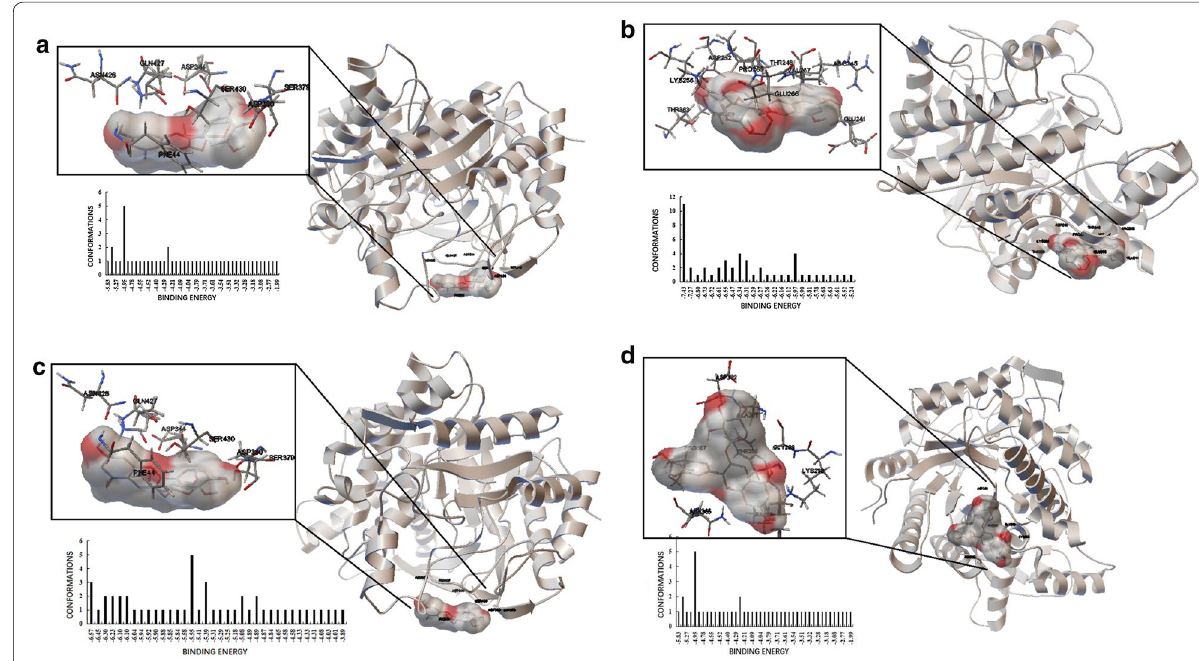
Fig. 6 Use Autodock software binding energy of 50 docking models. Panoramic view showing the binding mode between Cyanidin-3- O -arabinoside ( a ), Cyanidin-3- O -galactoside ( b ), Cyanidin-3- O -glucoside ( c ) and Cyanidin-3- O -Xyloside ( d ), and